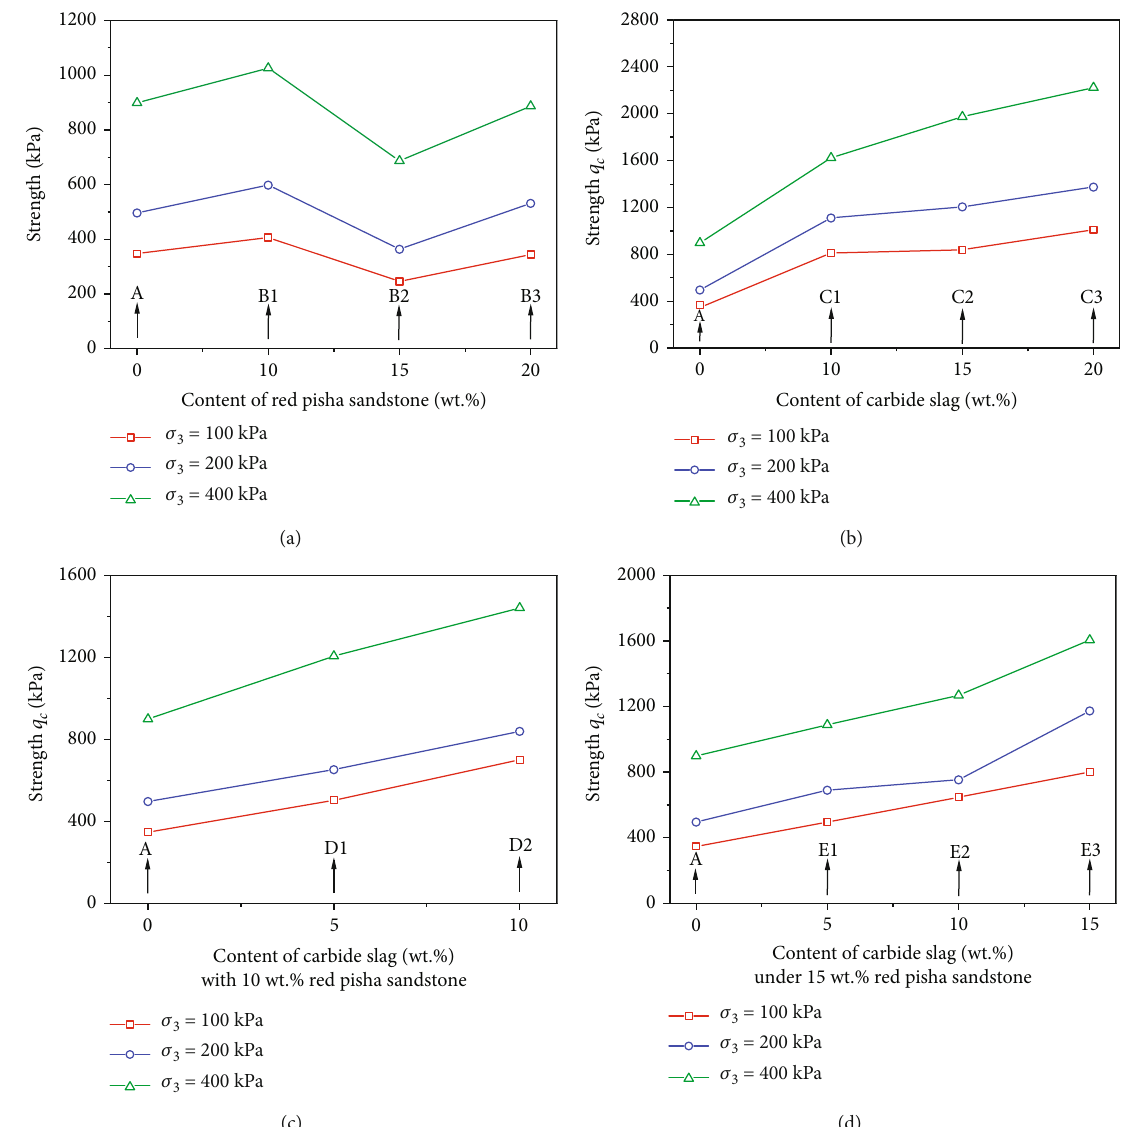
Figure 6: Strength of the modi fi ed soils under di ff erent con fi ning pressures: (a) the red Pisha sandstone modi fi ed soils; (b) the carbide slag modi fi ed soils; (c) the red Pisha sandstone and carbide slag modi fi ed soil; and (d) the red Pisha sandstone and carbide slag modi fi ed